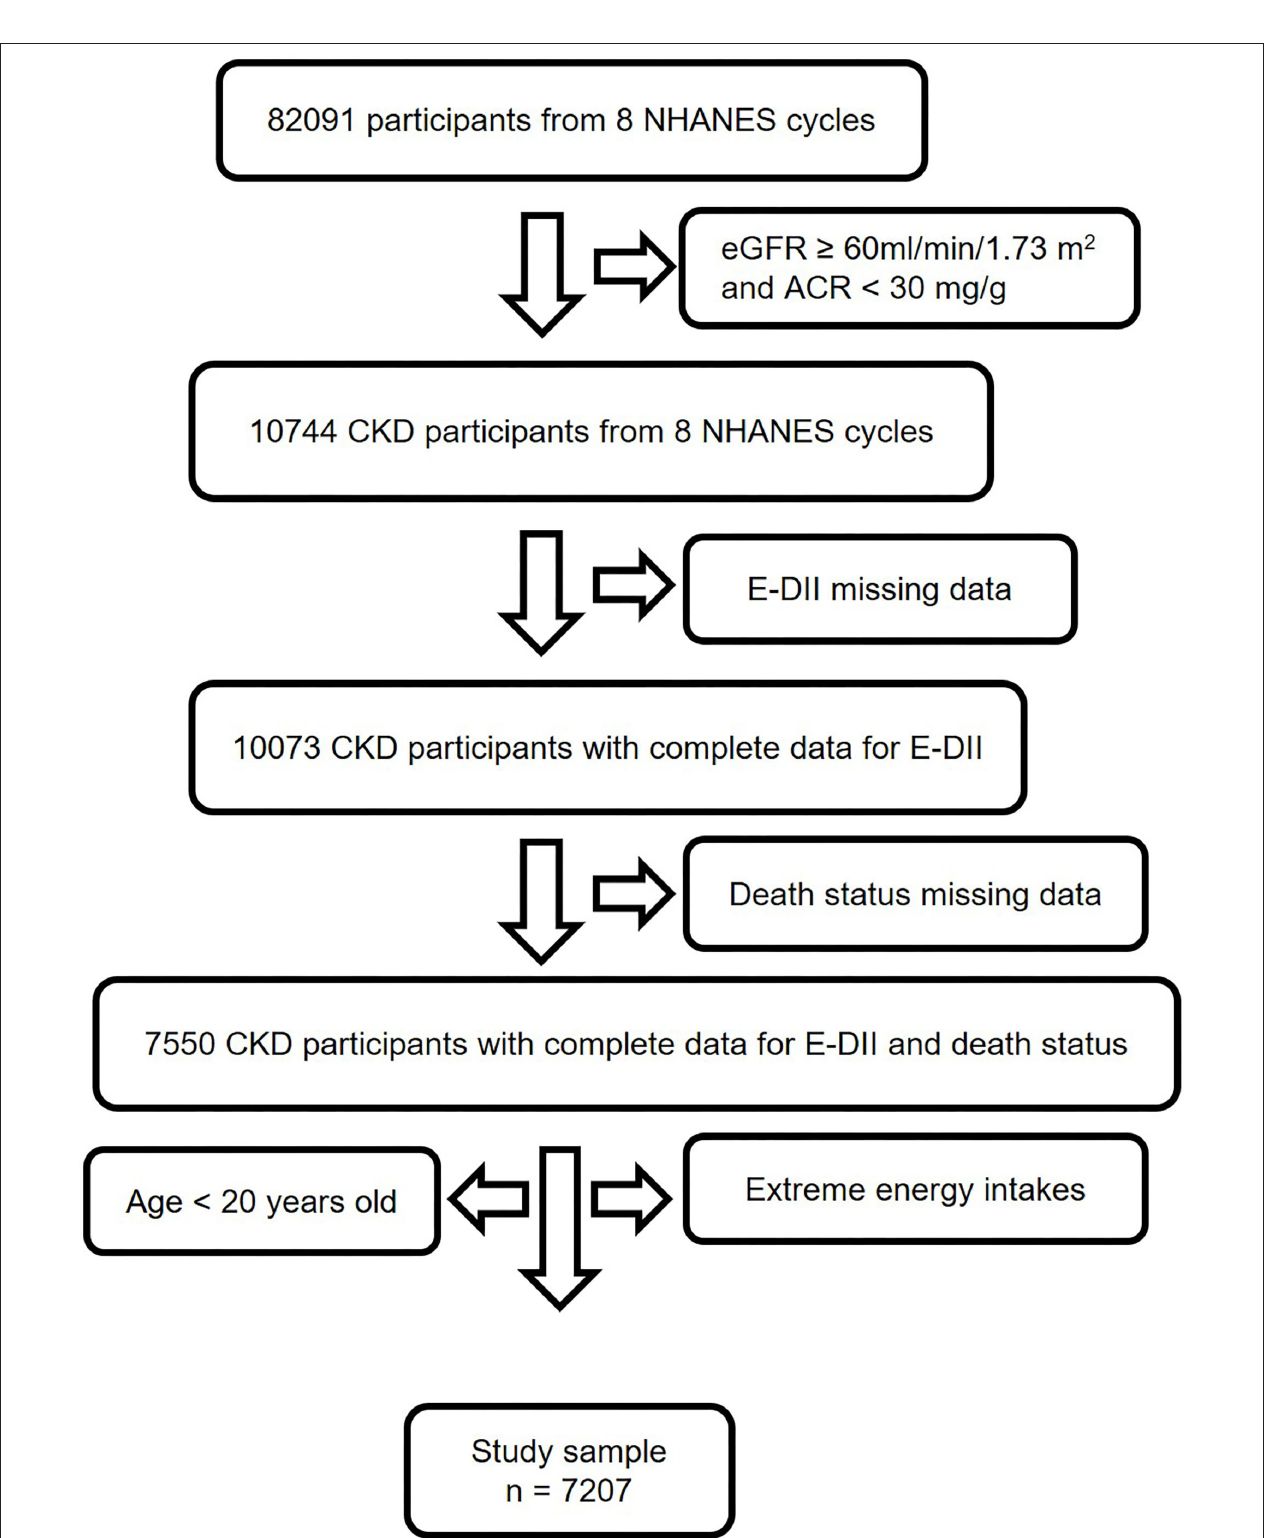
FIGURE 1 | Study flow chart. A total of 82,091 participants from NHANES 1999–2014 were involved in this study. Individuals with eGFR ≥ 60 ml/min/1.73 m 2 , ACR < 30 mg/g and age < 20 years old didn’t meet the inclusion criteria. After excluding subjects with missing data for E-DII, mortality, and extreme energy intake, 7,207 participants were finally used for analysis. CKD, chronic kidney disease; NHANES, National Health and Nutrition Examination Survey; E-DII, energy adjusted dietary inflammatory index; eGFR, estimate glomerular filtration rate; ACR, urine albumin to creatinine ratio.